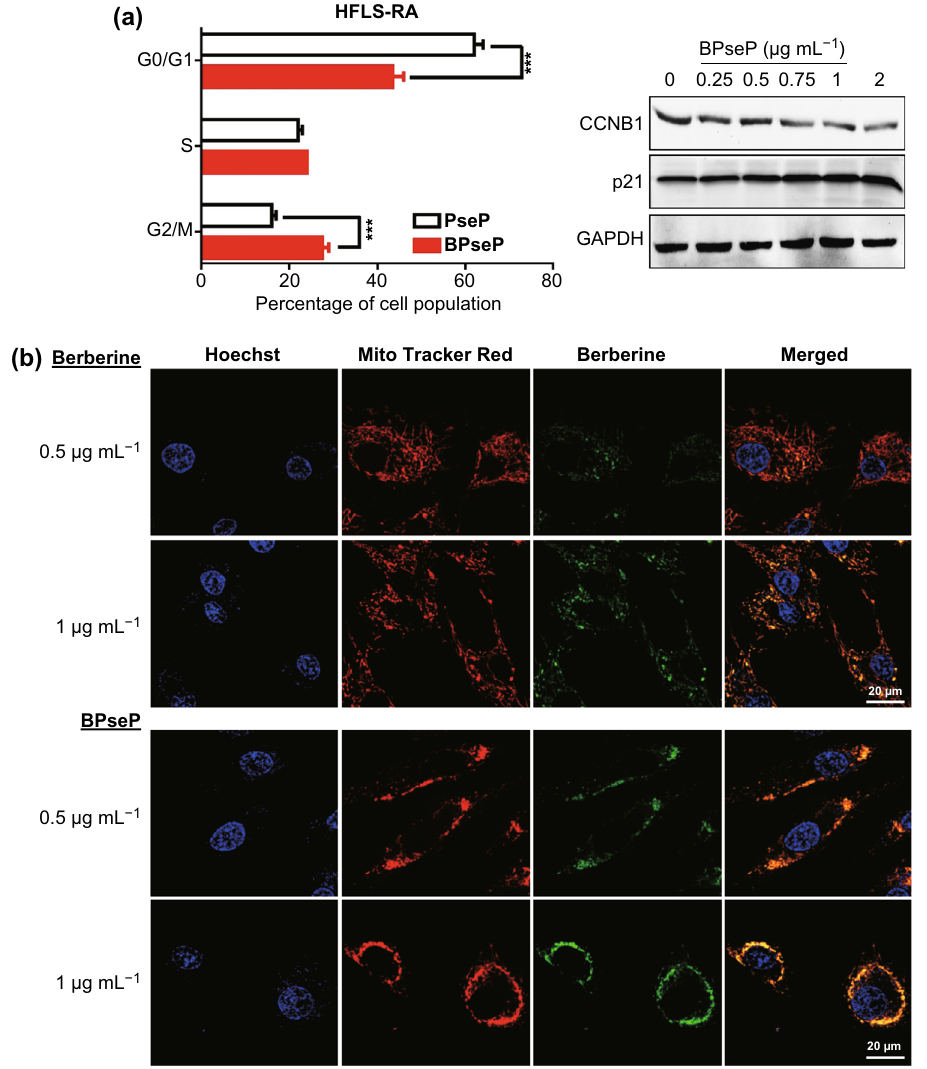
Fig. 4 a BPseP significantly caused G2 arrest, down‑regulation of CCNB1 and the increase of p21. b Immunofluorescence detection of berber‑ ine and mitochondria. The intracellular location of berberine was mostly overlapped with mitochondria. Data were analyzed as the mean ± SEM for triplicate individual experiments (* P < 0.05, ** P < 0.01, *** P <